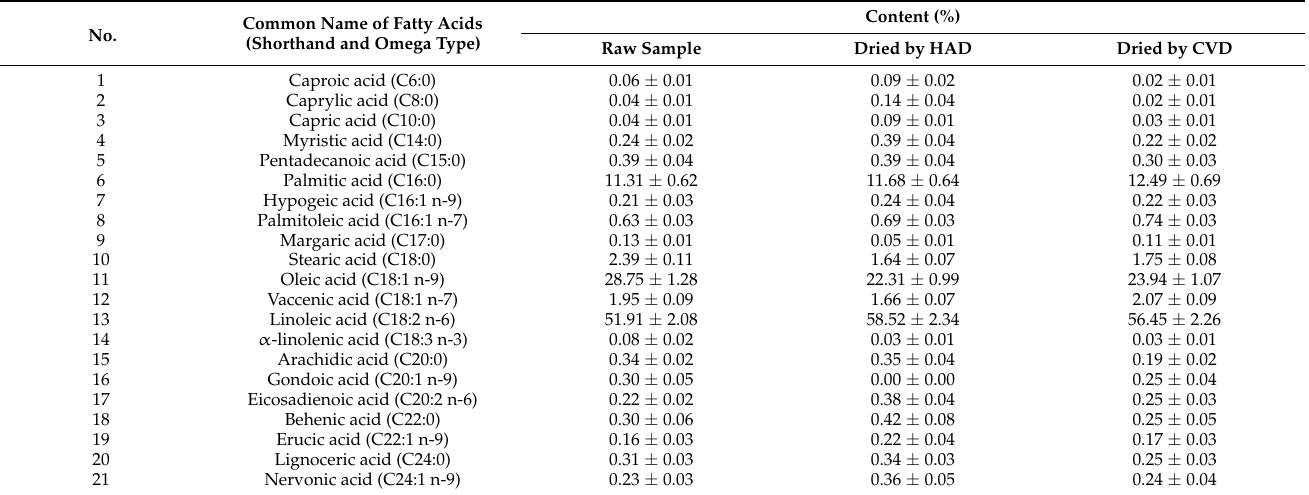
Table 2. Fatty acid profile of raw and dried B. edulis mushrooms (% of total fatty acid methyl esters FAMEs); data values are mean ±